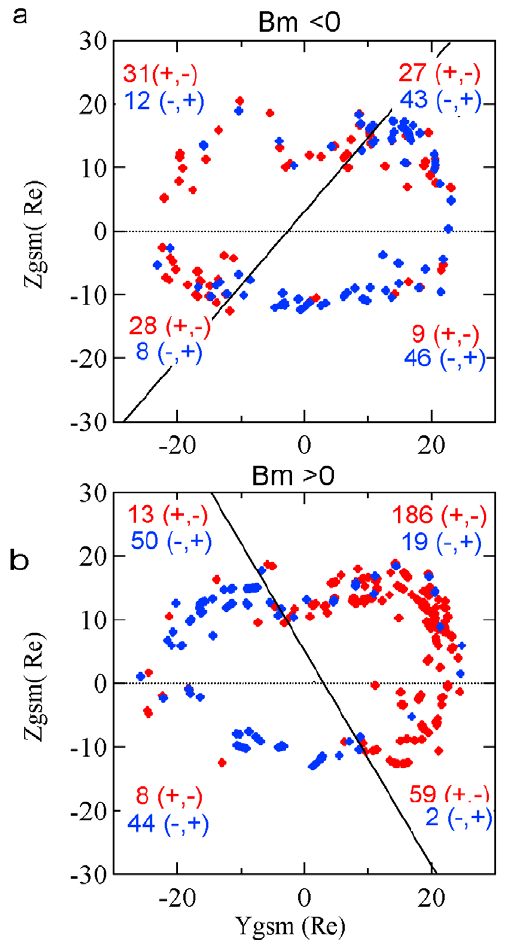
Fig. 11. Distributions of bipolar magnetic field signatures normal to the nominal magnetopause in the GSM Y-Z plane for duskward (Bm < 0) and dawnward (Bm > 0) magnetosheath magnetic field orientations. Red and blue crosses denote direct ( + , − ) and reverse ( − , + ) signatures in Bn component. The figure calls out the num- ber of magnetosheath events in sectors bounded by the equator and notional tilted reconnection